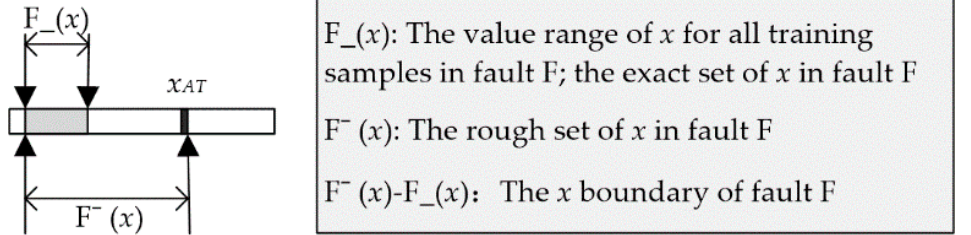
Figure 8. The rough set of fault F on the AT feature ( x AT ).